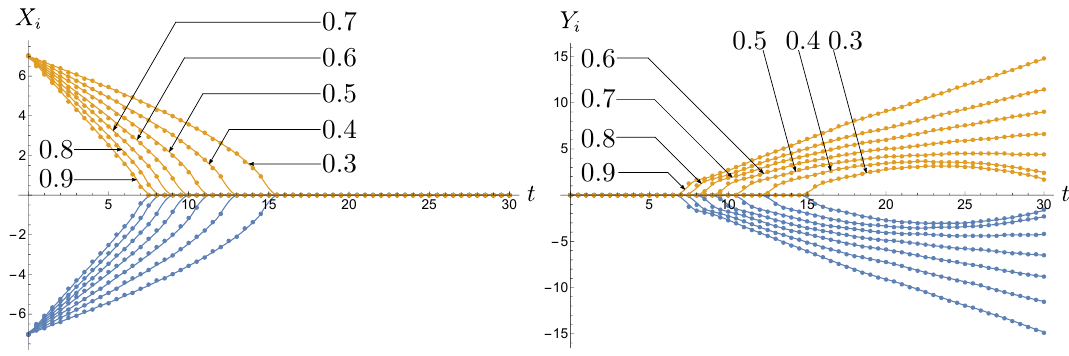
Figure 31 . Trajectories X i ( t ) and Y i ( t ) of the parallel non-Abelian vortices of type I*, for initial velocities u = 0 . 3 , 0 . 4 , · · · , 0 . 9 (marked on the plots for